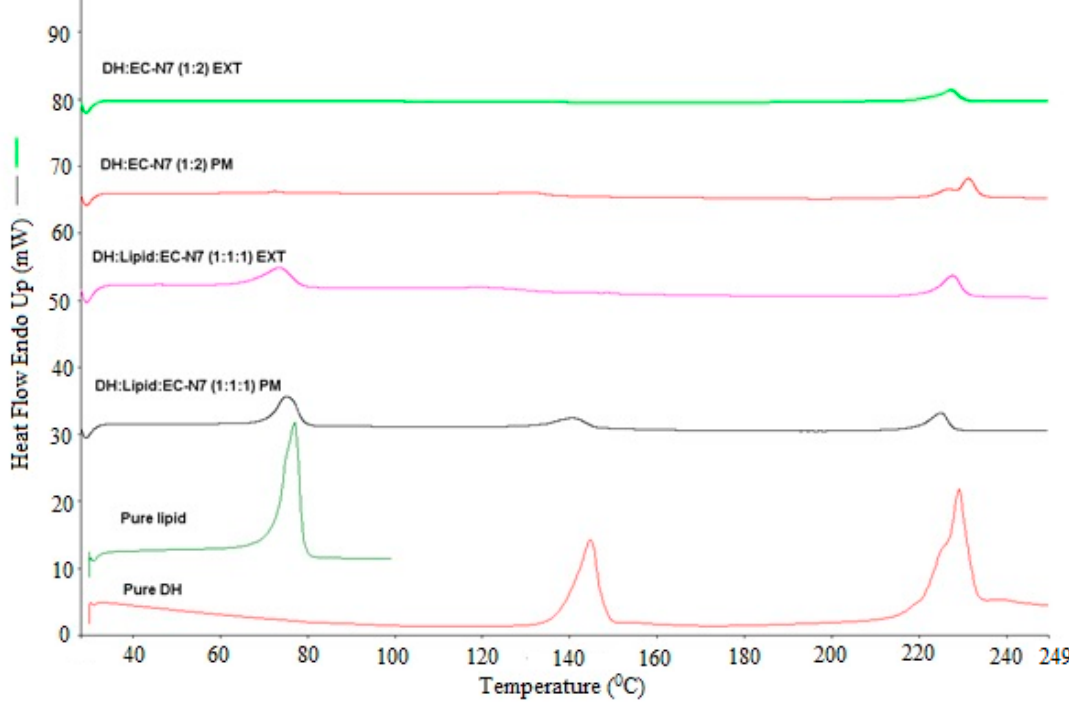
Figure 4. DH/C-888/EC-N7(1:1:1) and DH/EC-N7(1:2) DSC studies performed at temperatures of 30–250 °C and a heating rate of 20 °C/min.